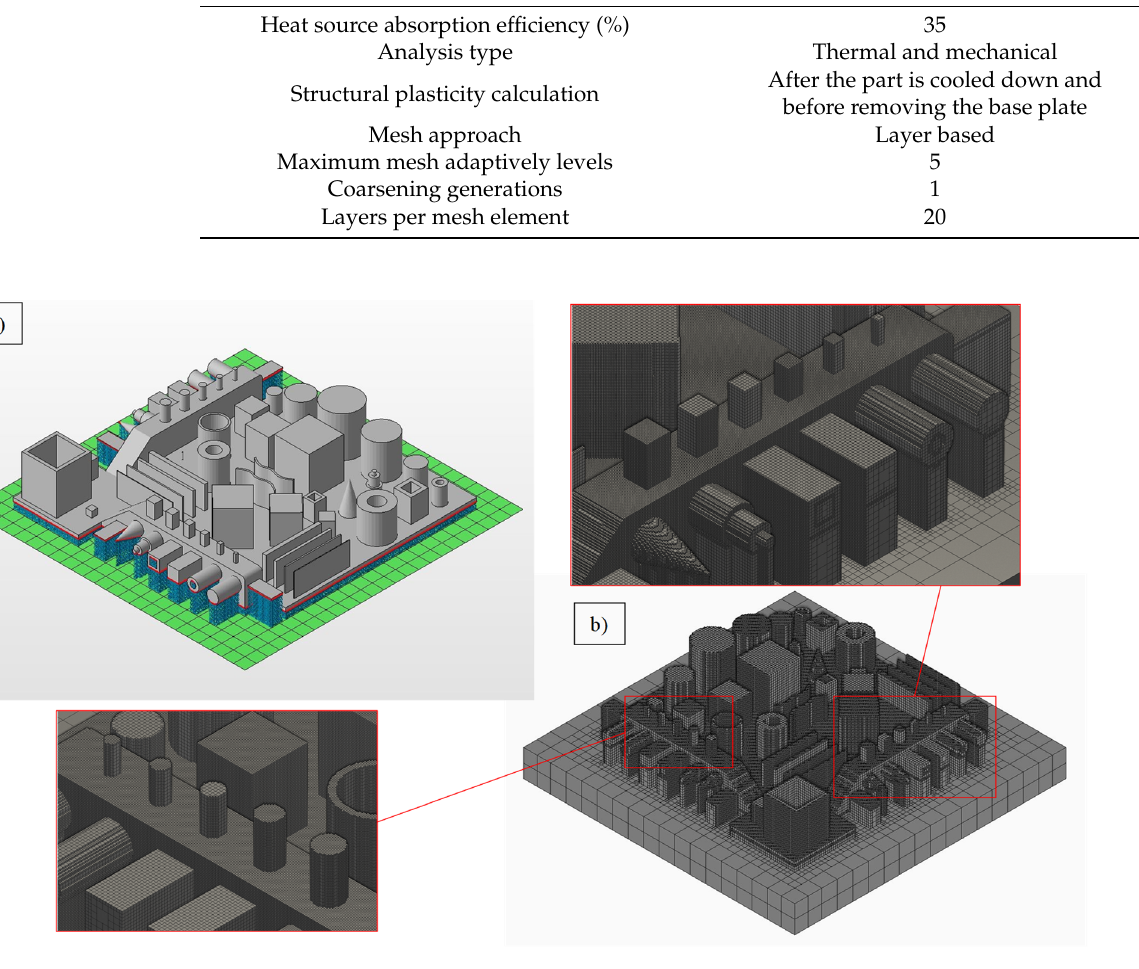
Figure 5. ( a ) GBTA with supports (in blue) and ( b ) layer-based adaptive coarsening mesh.